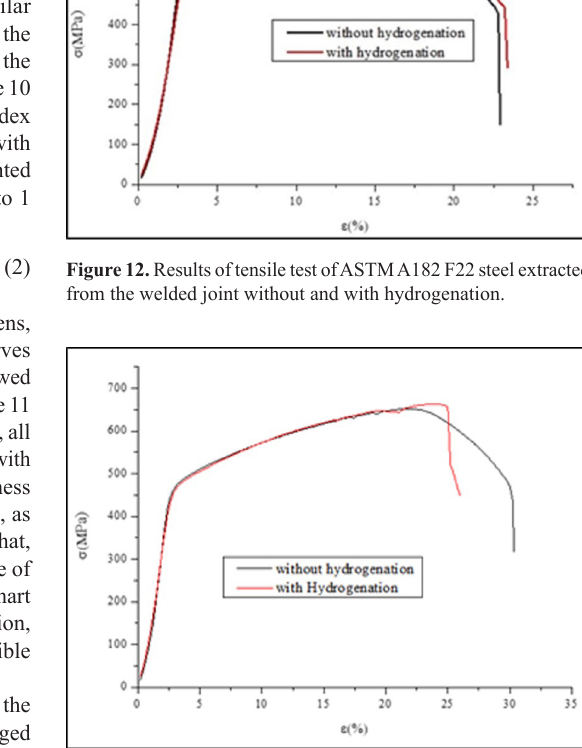
Figure 13. Results of tensile test of welded joint without and with